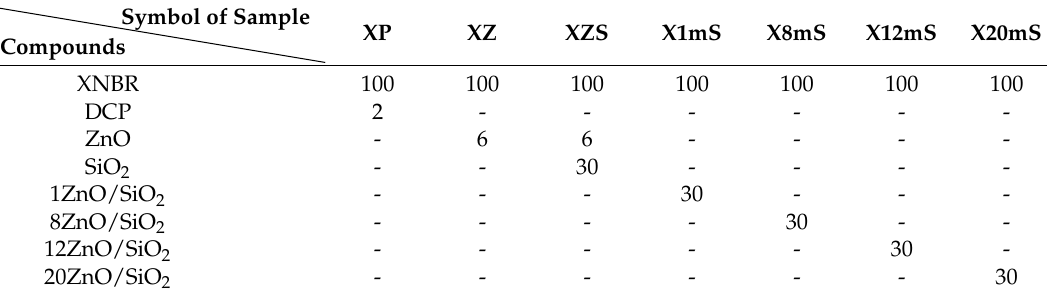
Table 2. Formulation of the rubber